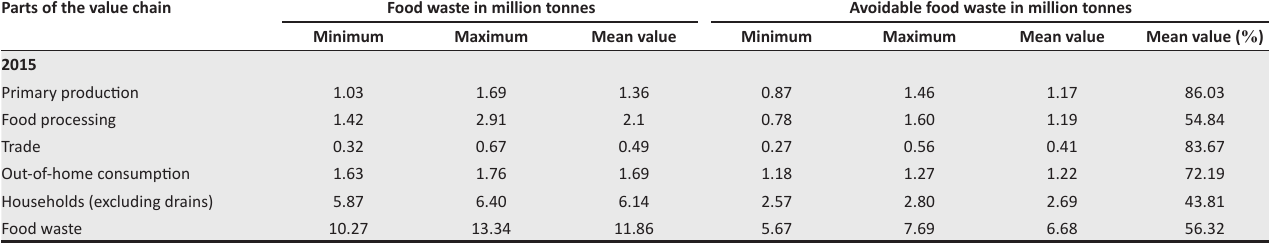
TABLE 1: German food waste in 2015: A summary of the results of the five subsections defined in the Baseline 2015 – with own interpretation. Parts of the value chain Food waste in million tonnes Avoidable food waste in million